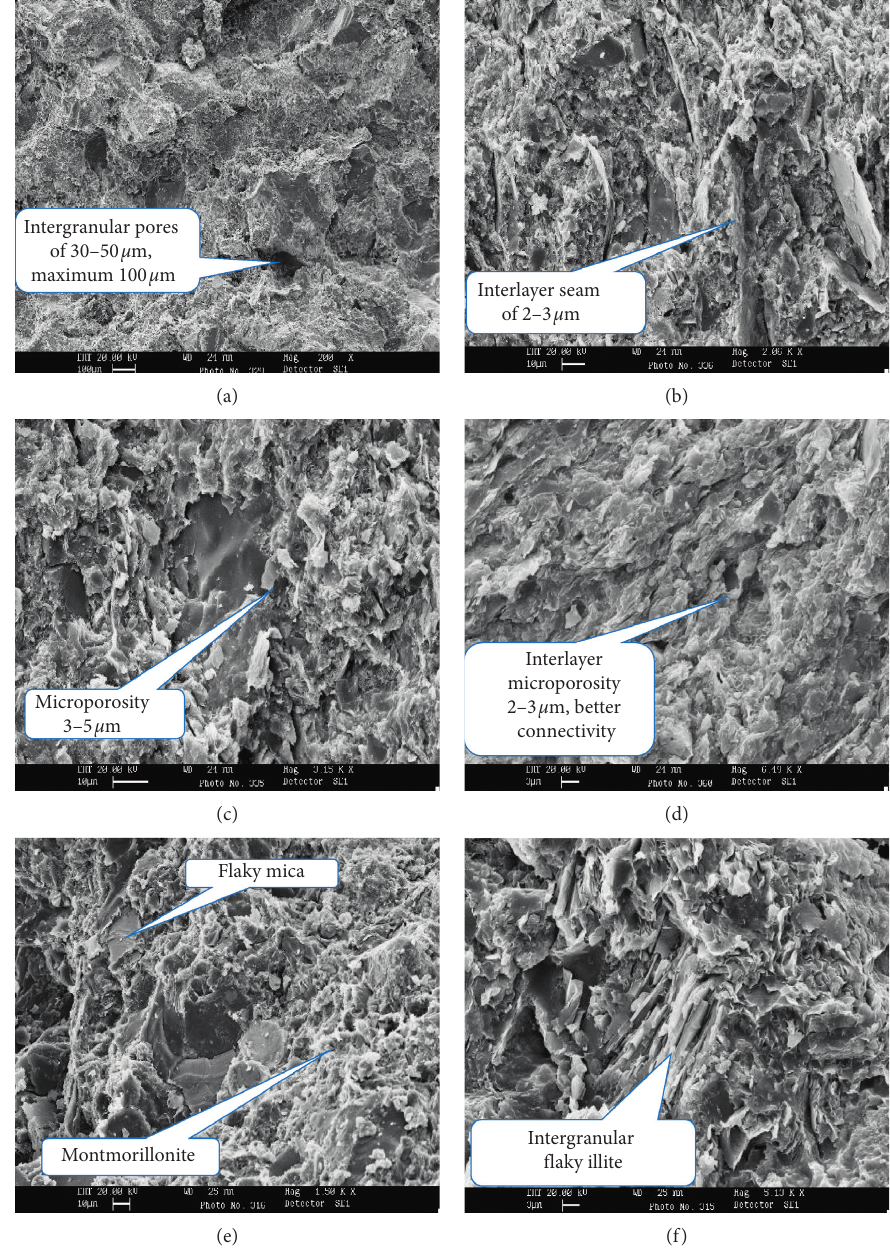
Figure 4: S-M scanning results. (a) Medium-grain sandstone (500 times magnification). (b) Medium-grain sandstone (1000 times magnification). (c) Mudstone (2000 times magnification). (d) Sandy mudstone (2000 times magnification). (e) Sandy mudstone (2000 times magnification). (f) Mudstone (3000 times